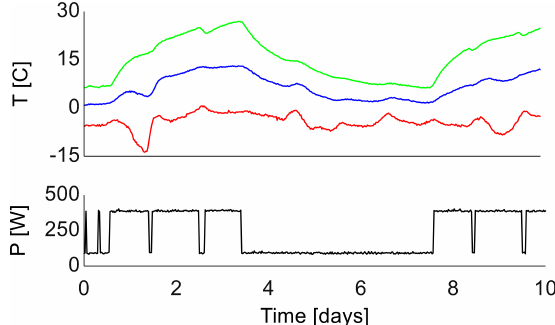
Figure 18: Calibration data for the R3C2 model. Temperatures T ∞ (red), T w (blue) and T b (green), and also the power consumption Q , was recorded in February